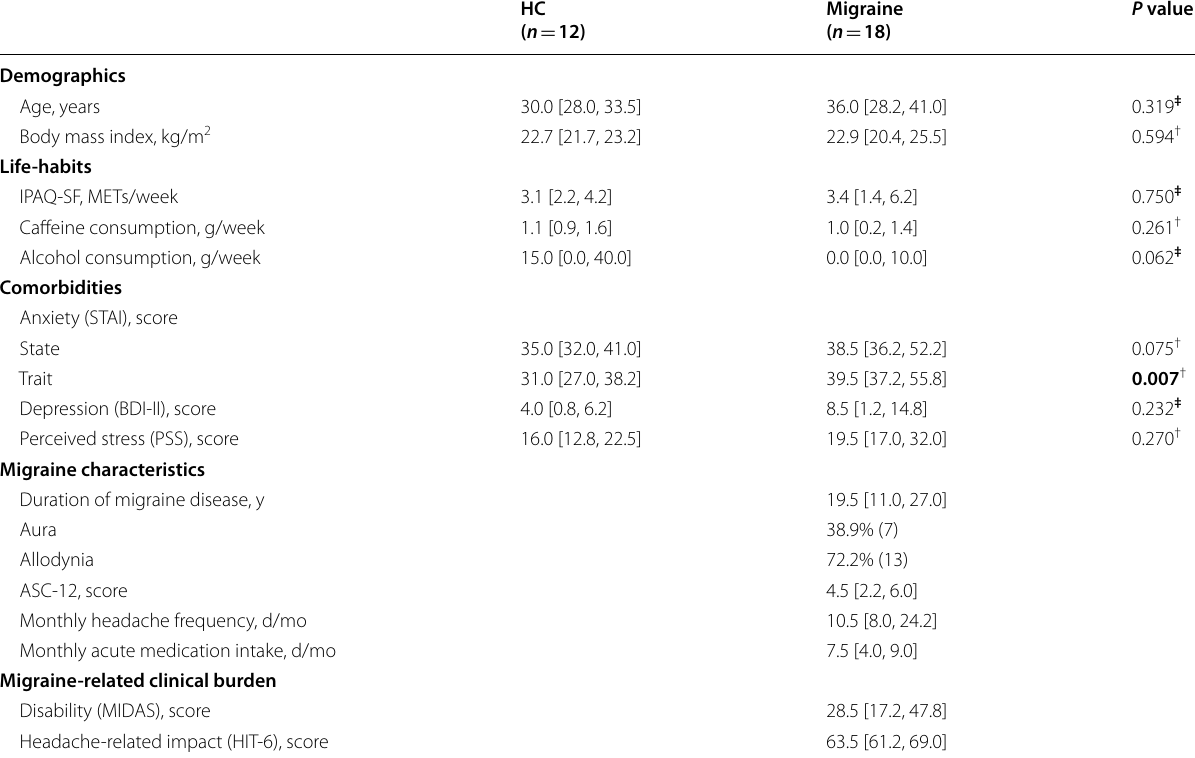
Continuous data is represented in median [IQR] and categorical data in %